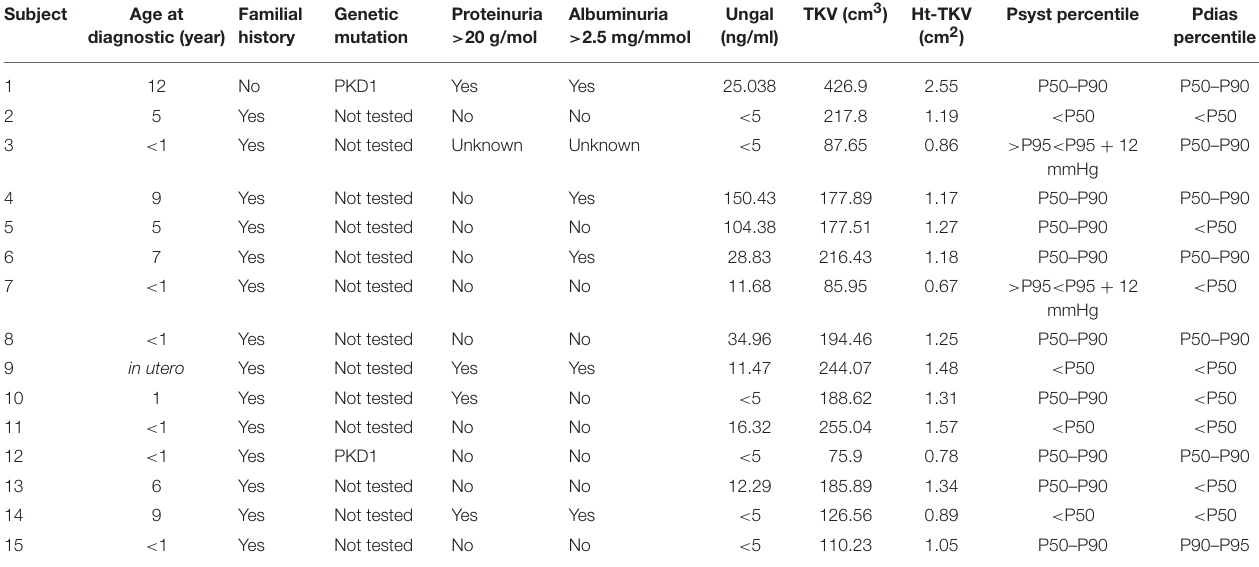
TABLE 2 | Clinical characteristics of ADPKD patients.